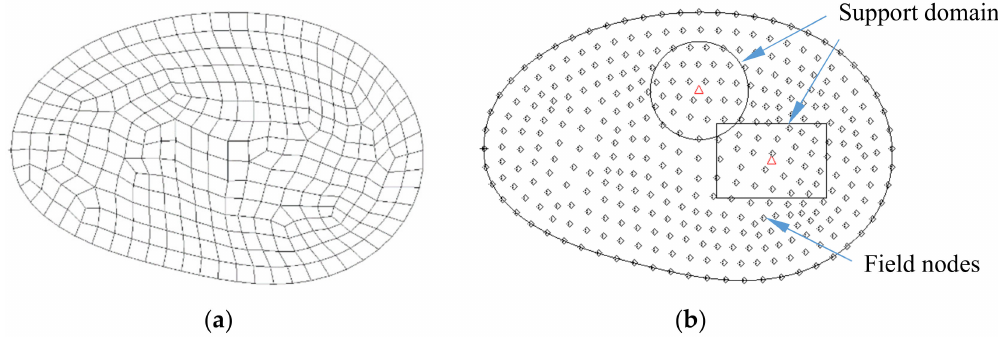
Figure 3. ( a ) Finite element method (FEM) with a local element; ( b ) meshfree approximation function constructed by field nodes within a support